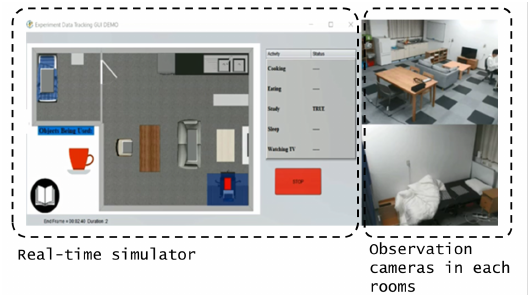
Figure 8. Collecting the data by the activity recognition system in CU smart home. All subjects were university students and this particular subject was studying at the time. The cup and book icons were appeared and the indicator of study changed to TRUE in the real-time